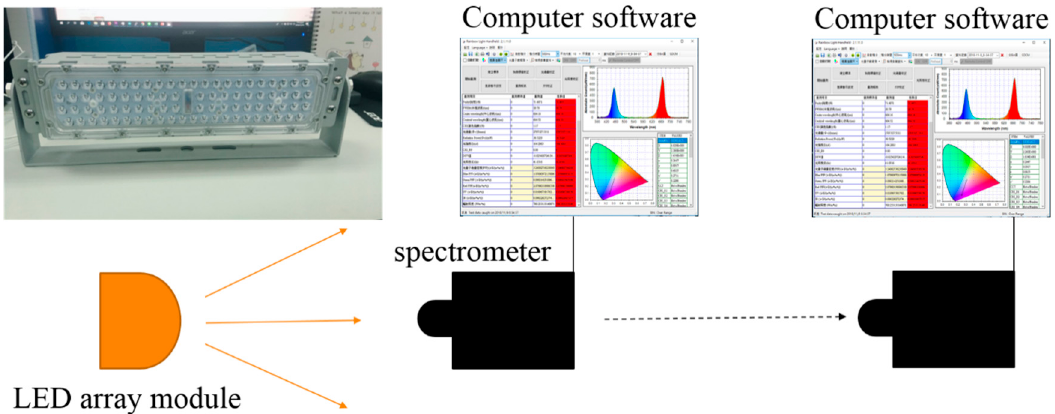
Figure 3. New design of the LED module with different arrangements of red and blue LED bulbs, and the schematic of measurement of the red and blue light intensity corresponding to the distance. The ratio of red to blue LED bulbs inside the LED modules was 6:1.